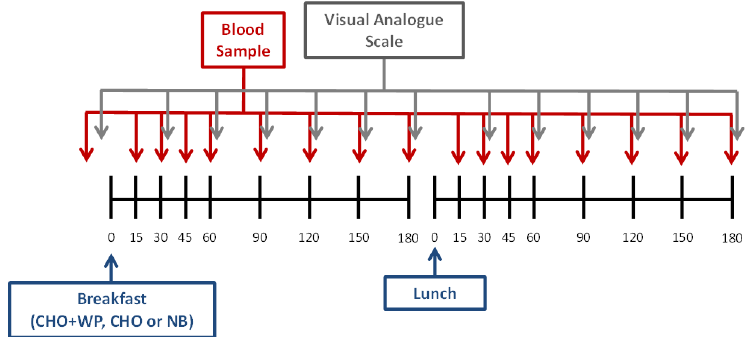
Figure 1. Schematic layout of experimental trials. CHO: high ‐ carbohydrate breakfast trial; CHO + WP: high ‐ carbohydrate breakfast with added whey protein trial; NB: no breakfast trial.